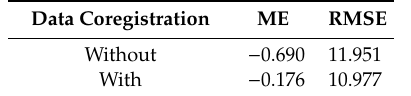
Table 3. Accuracy assessment of the RF-enhanced DEMs with and without data coregistration relative to GNSS points